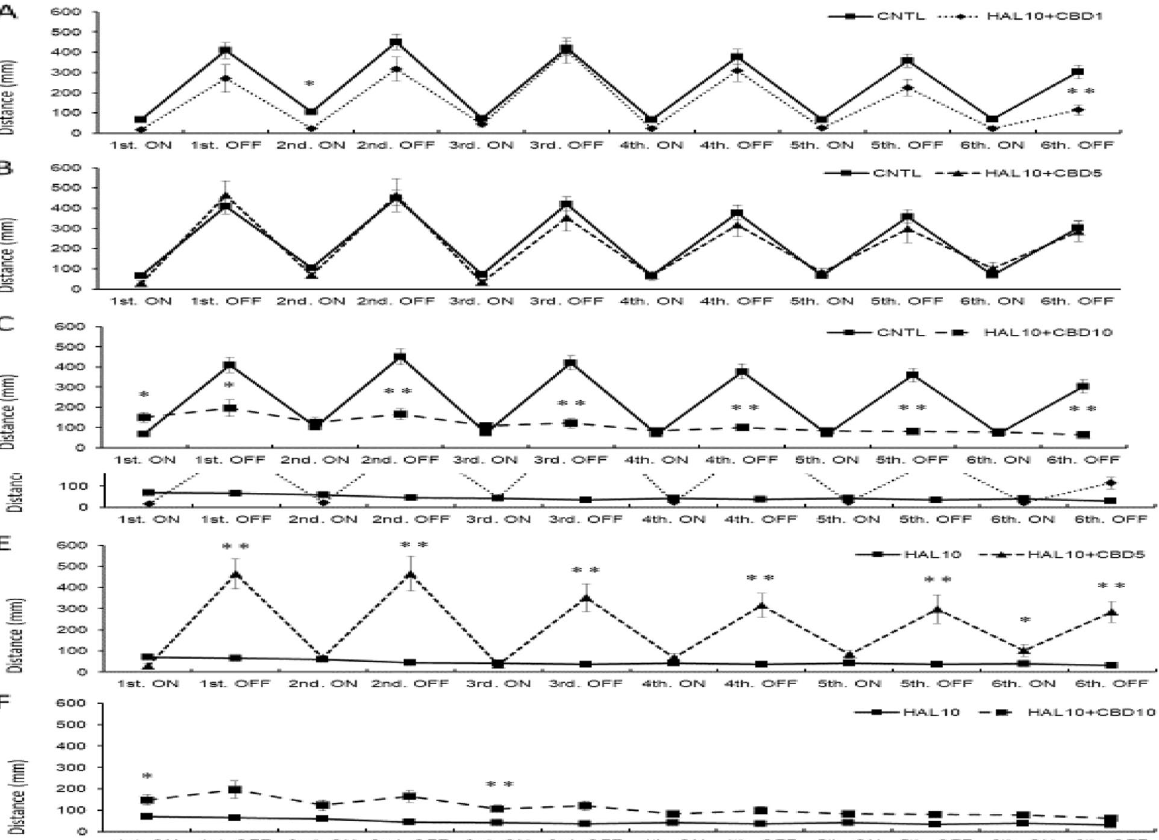
Fig. 4. Effect of HAL 10 mg /L ROP on light/dark-stimulatory response. In the HAL 10 mg/L ROP 1 mg/L group, the response was enhanced + + in the first light condition compared to the CNTL; however, the response was significantly decreased in the second to sixth dark conditions ( a ). In the HAL 10 mg/L ROP 5 mg/L group, the response significantly increased in all light conditions compared to the CNTL. However, the response + significantly decreased in all dark conditions ( b ). In the HAL 10 mg/L ROP 10 mg/L group, there was no significant difference in all dark conditions + compared to the CNTL, but the response was enhanced from the first to fifth light conditions ( c ). The HAL 10 mg/L ROP 1 mg/L group was + significantly enhanced only in the first light condition compared with the HAL 10 mg/L group ( d ). The HAL 10 mg/L ROP 5 mg/L group had a + significantly enhanced response in all light conditions compared to the HAL 10 mg/L group ( e ). In the HAL 10 mg/L ROP 10 mg/L group, the + response was improved in all dark conditions, compared to the HAL 10 mg/L, whereas the response was enhanced in all light conditions ( f ). CNTL: Control, HAL 10: Haloperidol 10 mg/L, ROP 1, 5, 10: Ropinirole 1, 5, 10 mg/L, ON: light-on period, OFF: light-off period. Tukey–Kramer test; * p <0.05, ** p <0.01 from the CNTL vs HAL 10 ROP groups. All values are presented as means SEMs ( n + ± =